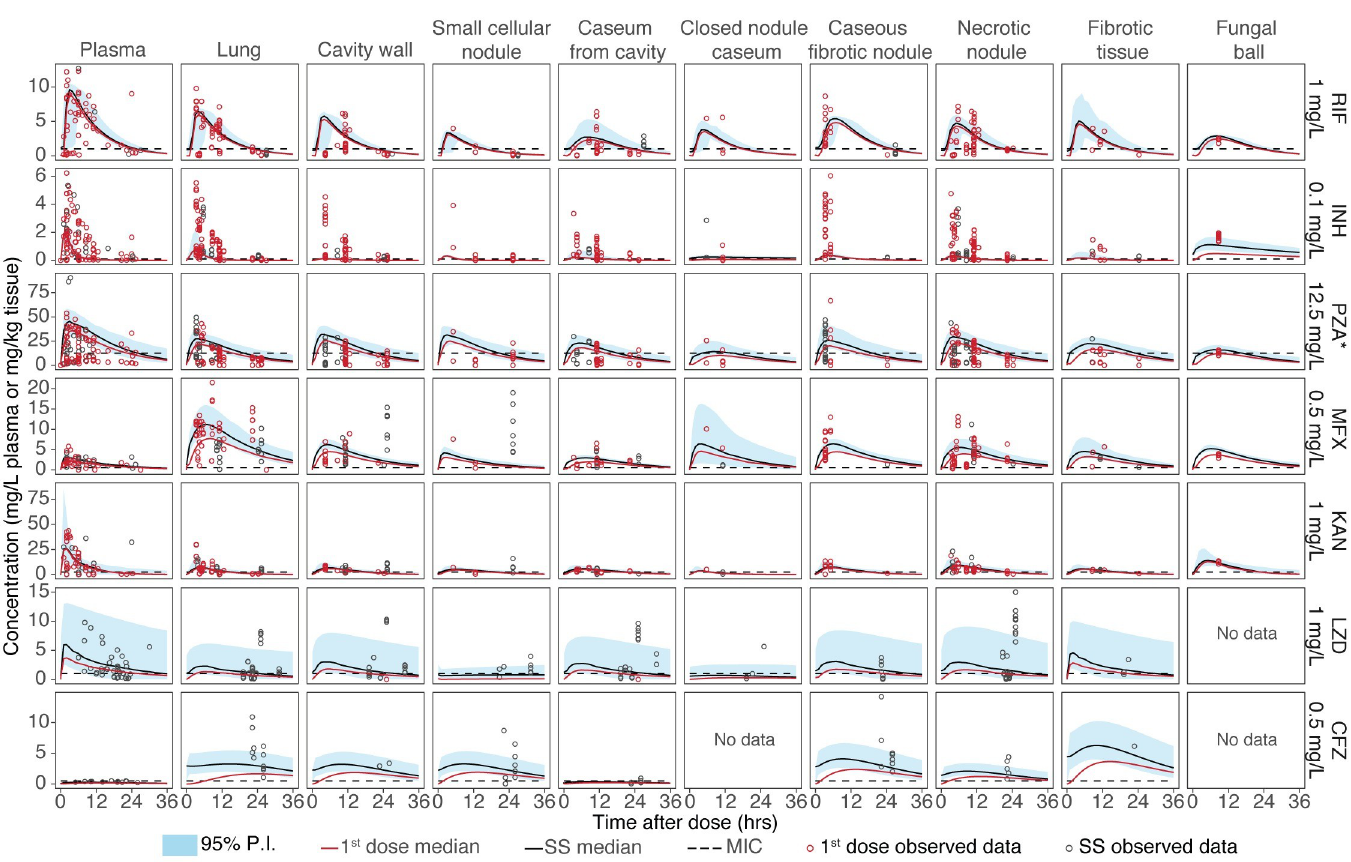
Fig 4. Visual predictive check of individual lesions and drugs. The visual predictive checks were simulated for 1,000 patients and are shown for all 7 drugs and 9 lesions. The simulated concentration–time profiles are represented by a solid black line to represent the median (typical patient) at steady state, with the shaded light blue area representing the 95% prediction interval of the 1,000 patients simulated. The red line represents the median of plasma–time concentrations after the first dose of each respective drug. The dashed black line represents the respective MIC of each drug and is displayed below the drug name. The original observed data is overlaid on top of the simulated bands as open circles to assess the ability of the model to capture both the median and distribution of the clinical data. Open red circles represent drug concentrations of patients receiving their first doses, and black open circles represent observed data for patients who were at steady state at the time of resection. First dose and steady state are overlaid in a single panel. A time-extended plasma visual predictive check is provided in S3 Fig. � PZA MIC of 12.5 mg/L is shown and is specific to an acidic environment less than pH 5.8. MIC, minimum inhibitory concentration; CFZ, clofazimine; INH, isoniazid; KAN, kanamycin; LZD, linezolid; MFX, moxifloxacin; NA, not available; PZA, pyrazinamide; RIF,